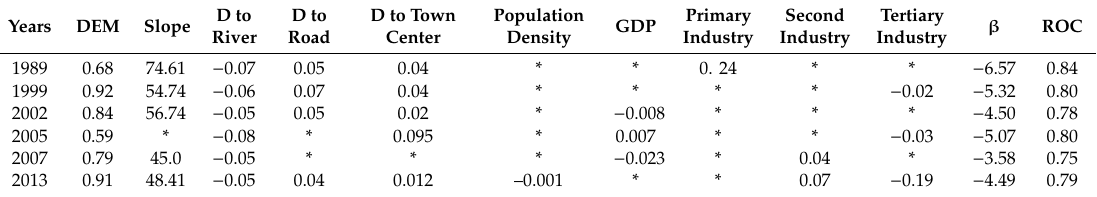
Table 3. Values of β from logistic regression of spatial distribution for built-up areas in di ff erent years. Years DEM